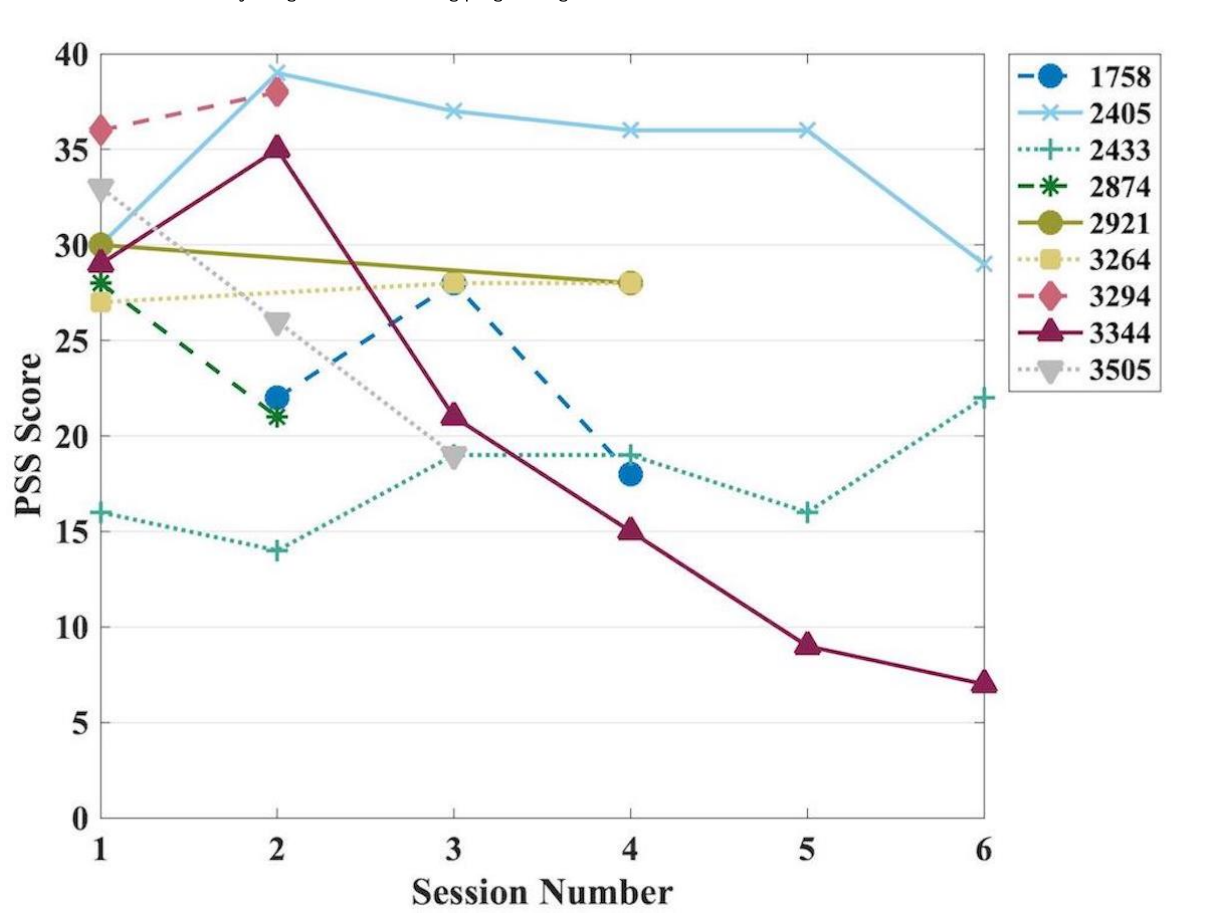
Figure 2. Change in stress levels across sessions one through six measured using PSS scores. The figure legend's four-digit values correspond to the identification numbers randomly assigned to users during program registration. PSS: Perceived Stress